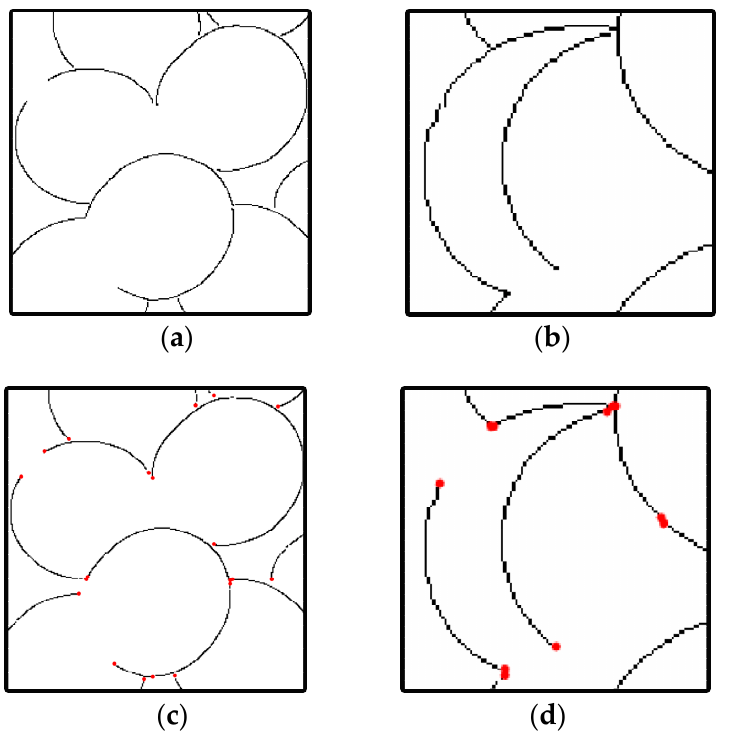
Figure 6. Concave point detection and edge contour segmentation of grape berries with different overlapping degrees. ( a , b ) are the berry edge contours with different degrees of overlap. The red points on ( c , d ) indicate the division points of the grape contour.